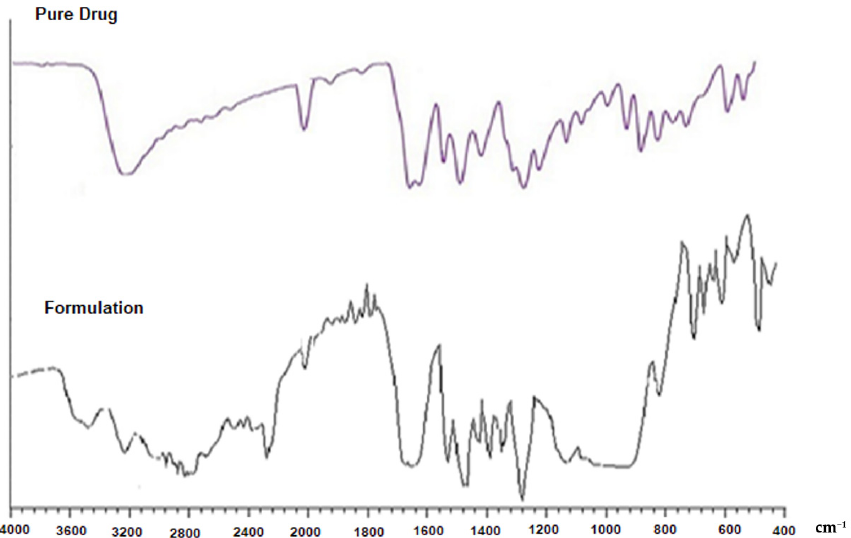
Figure 2. FTIR spectra of the Kaempferol (pure drug) and the prepared Kaempferol nanoparticle.